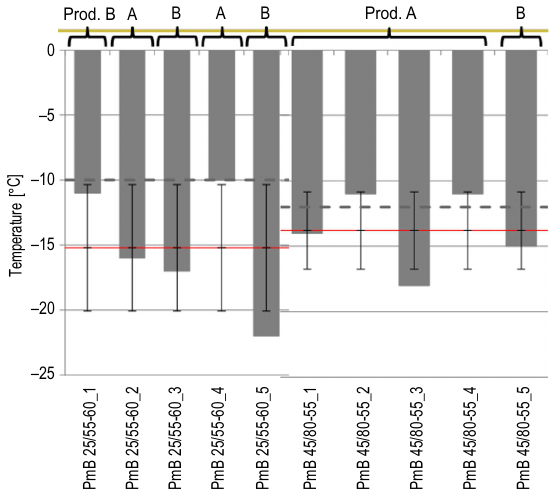
Fig. 6. Polymer modified bitumen Fraass breaking point